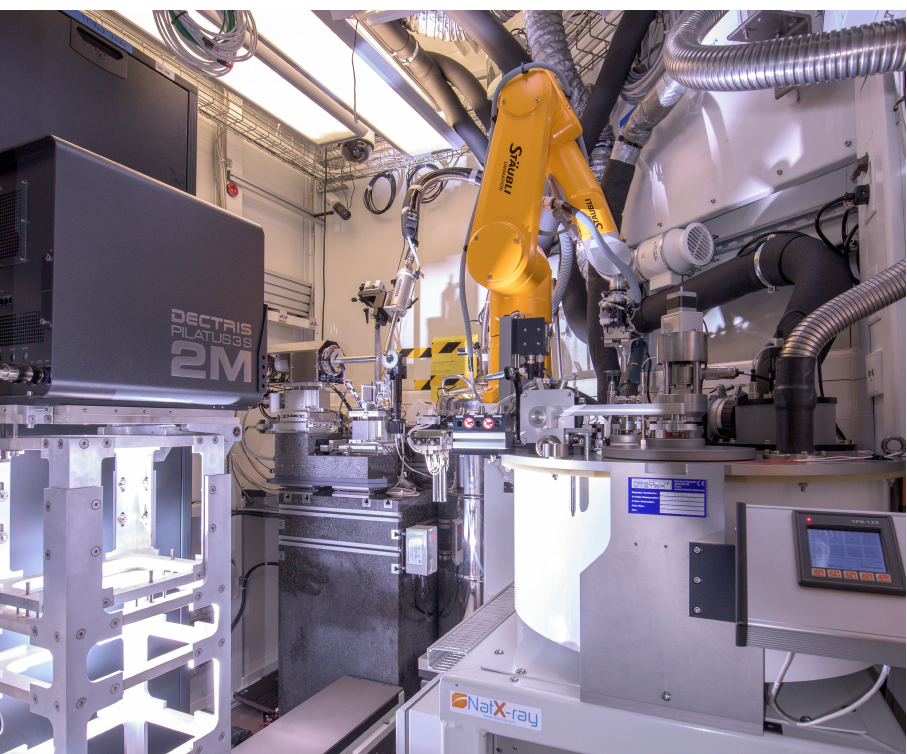
Figure 2: Experimental station of beamline BL14.2